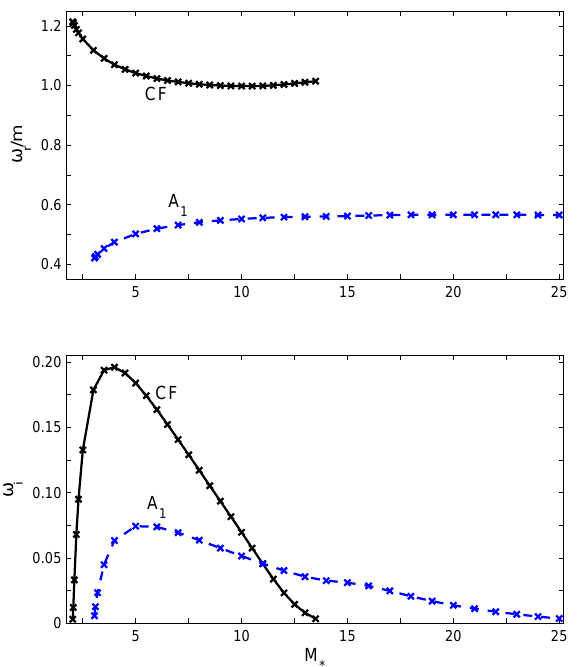
Figure 8. The eigenvalues of the main unstable branches of the m = 2 harmonic, depending on the parameter M * , at fixed value of parameter R = 0.96. The model gas disk has the same other σ parameters, as described in Figure